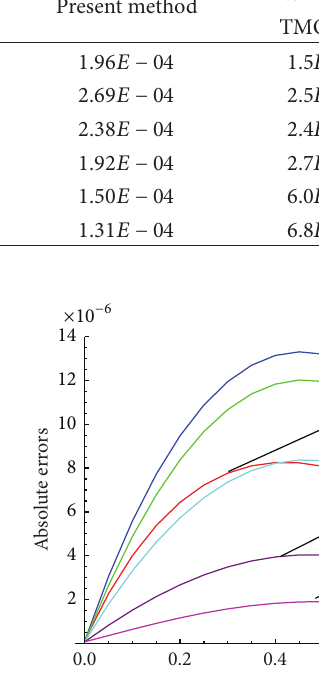
Figure 1: Absolute errors of numerical values at different time levels for Example 1 by using ℎ = 0.05 and 𝑘 = 0.001 .